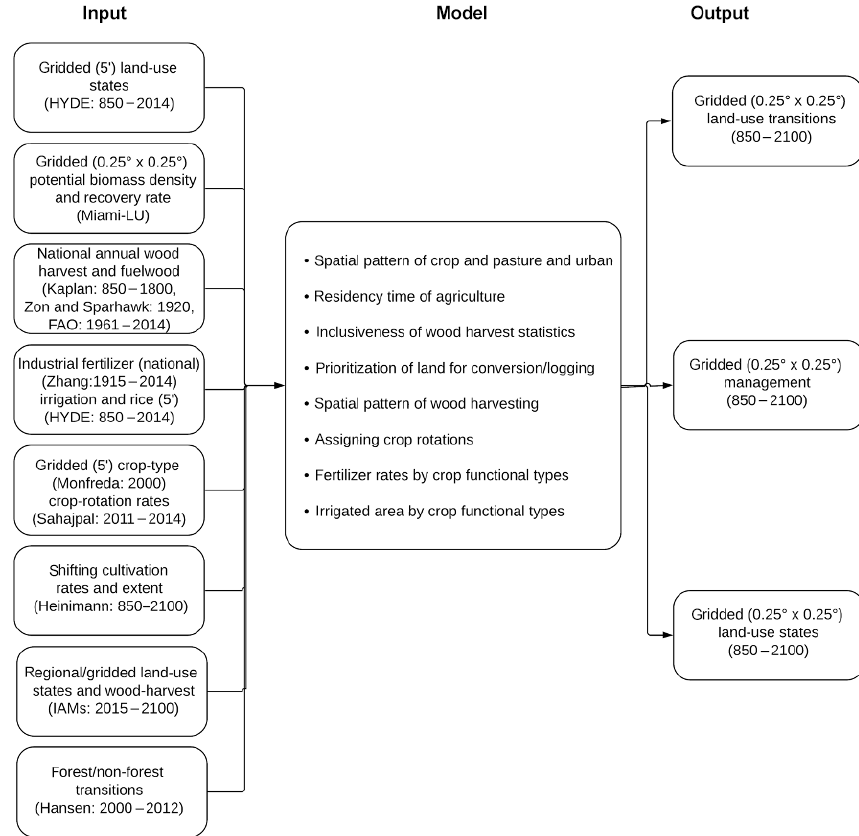
Figure 1. Schematic diagram of major model inputs, decisions, and